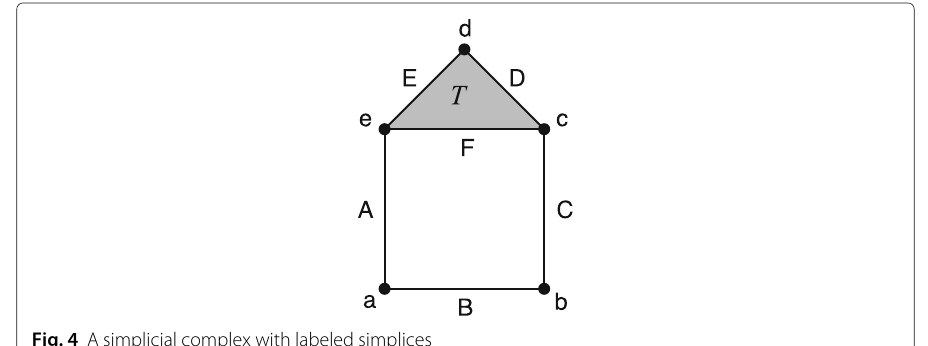
Fig. 4 A simplicial complex with labeled